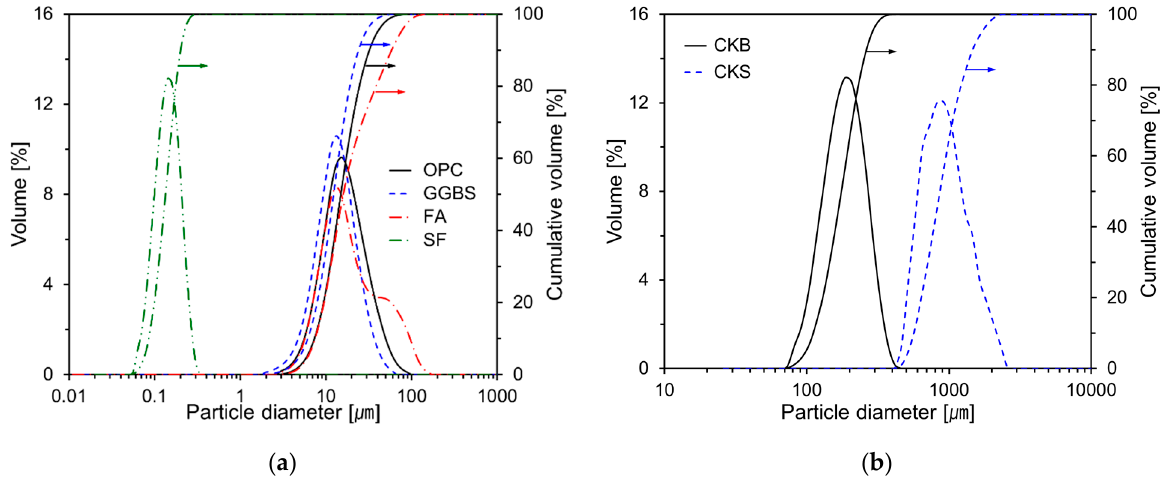
Figure 1. Particle size distributions of raw materials: ( a ) OPC, GGBS, FA, SF; ( b ) CKB, CKS.